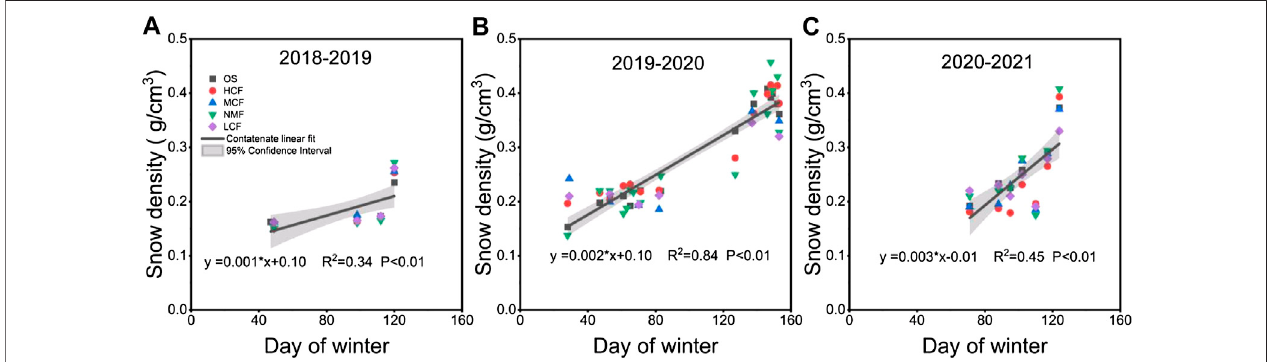
FIGURE 5 | Relationship of snow density ( ρ ) with day of winter (DOW) for 3 years at fi ve sites: (A) 2018 – 2019, (B) 2019 – 2020, and (C) 2020 – 2021. Day of winter (DOW)representsthenumberofdays,startingfromNovember1totheseasonalendofApril8.Thedifferenticonsindicatedifferentlandtypes:OS,opensite;HCF,high- intensity cutting mixed forest; MCF, moderate-intensity cutting mixed forest; NMF, natural mixed forests; LCF, low-intensity cutting mixed forest. The solid line is a fi tted regression for snow density and DOW for all land types, and the shaded range indicates the 95% conference interval.